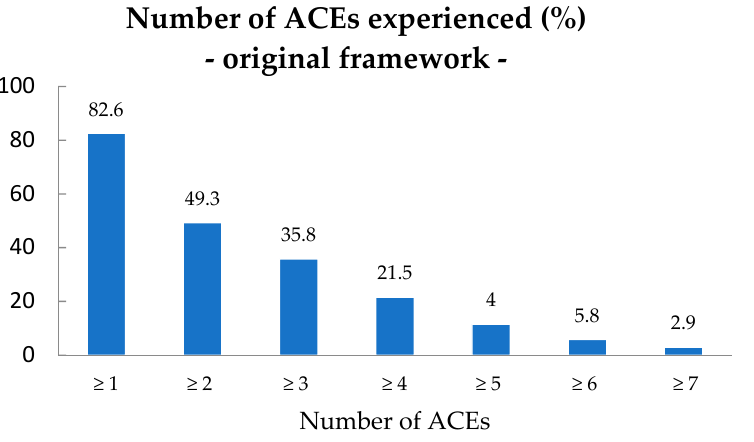
Figure 1. Number of ACEs from the original ACEs framework in children with ID, n = 69. ACEs: Adverse Childhood Experiences; ID: intellectual disabilities.